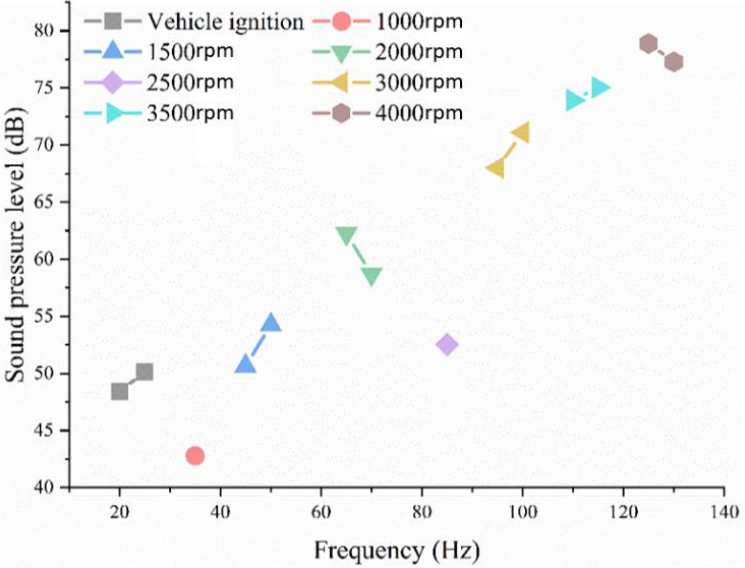
Figure 7. Main noise frequency contribution analysis diagram of the vehicle engine.